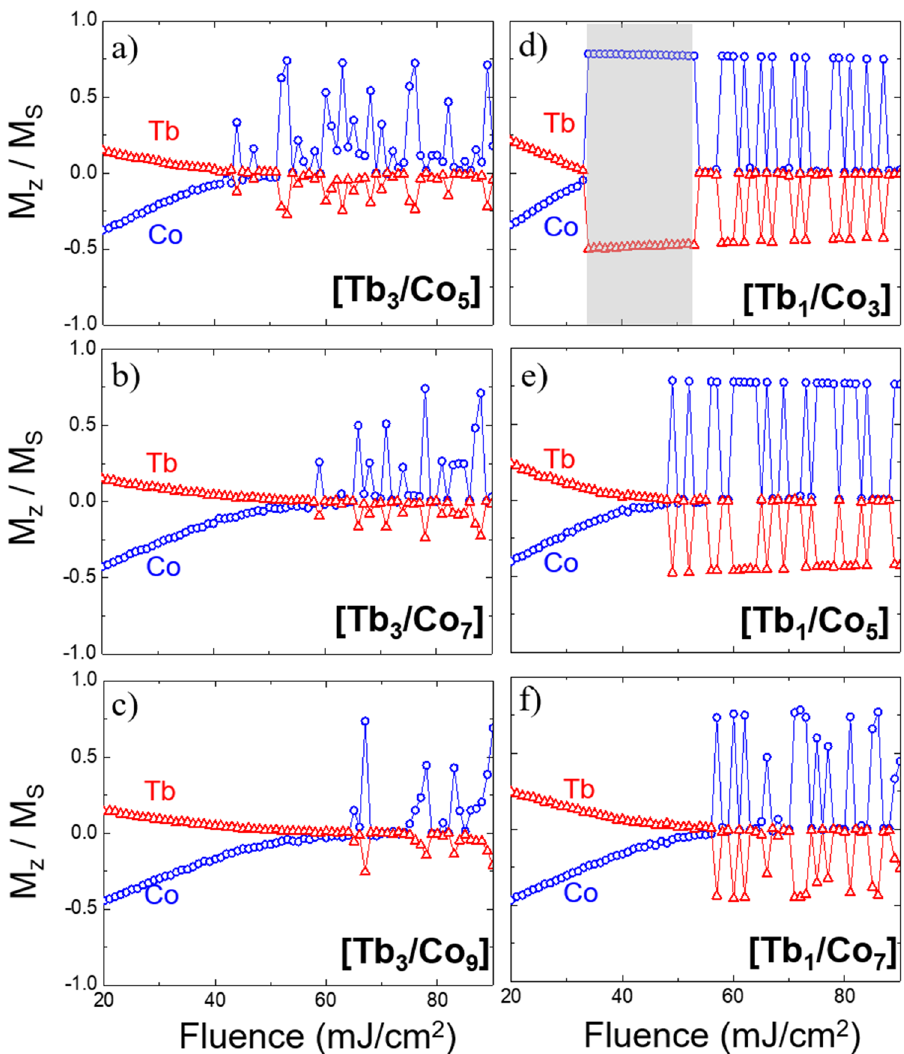
Figure 2. Normalized magnetization of Tb and Co sublattices as a function of the laser fluence. M z / M s ratios are extracted from the magnetization curves of the [ Tb n / Co m ] multilayers 20 ps after the single laser pulse has interacted with the system. Each peak indicates switching, where Tb goes to a negative magnetization and Co goes to a positive magnetization. The noise observed in these graphs reflects the impact of random thermal fluctuations on the switching dynamics. A deterministic switching window is marked with light grey color for [ Tb 1 / Co 3 ]